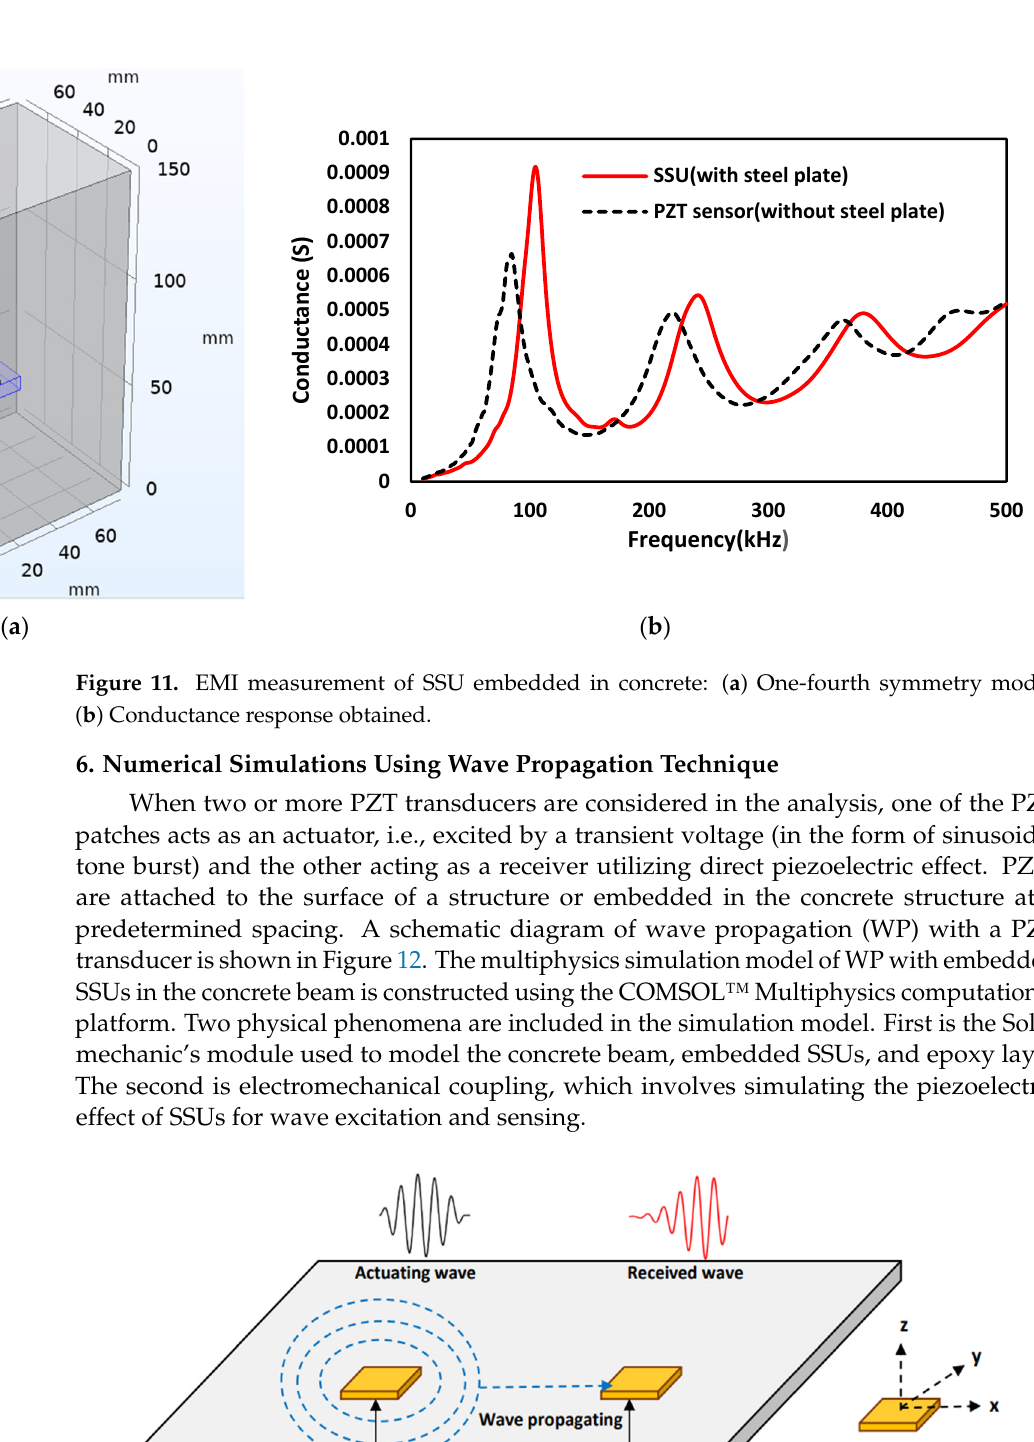
Figure 10. EMI response of SSU: ( a ) Schematic two-sided symmetry model of SSU; ( b ) Conductance and susceptance signatures obtained in a free–free mode of PZT sensors (without steel plate) and free–free mode SSU (with steel plate).